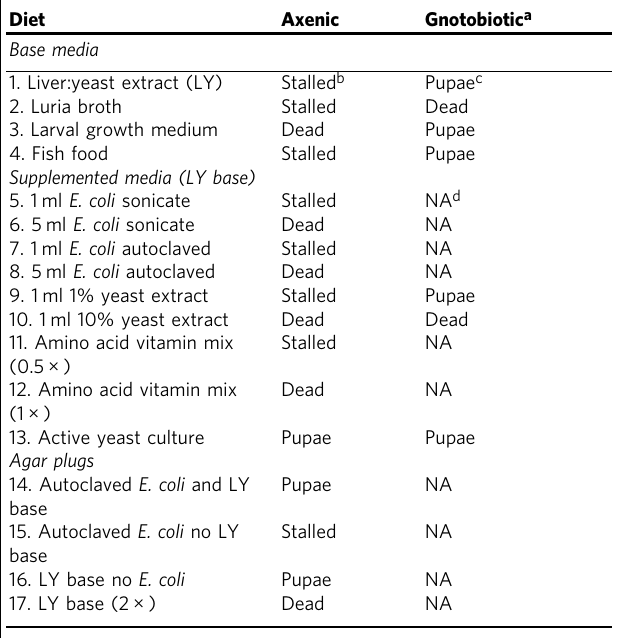
Table 1 Effect of sterile diets on larval development Diet Axenic Gnotobiotic